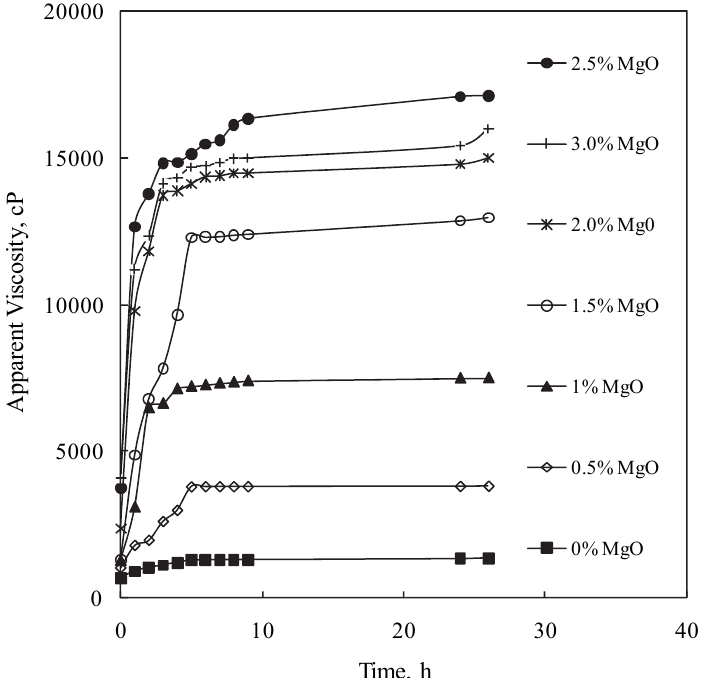
Fig. 2 Variation of viscosity with time for Na-Bentonite + MgO suspensions at different MgO additions (LV2-30